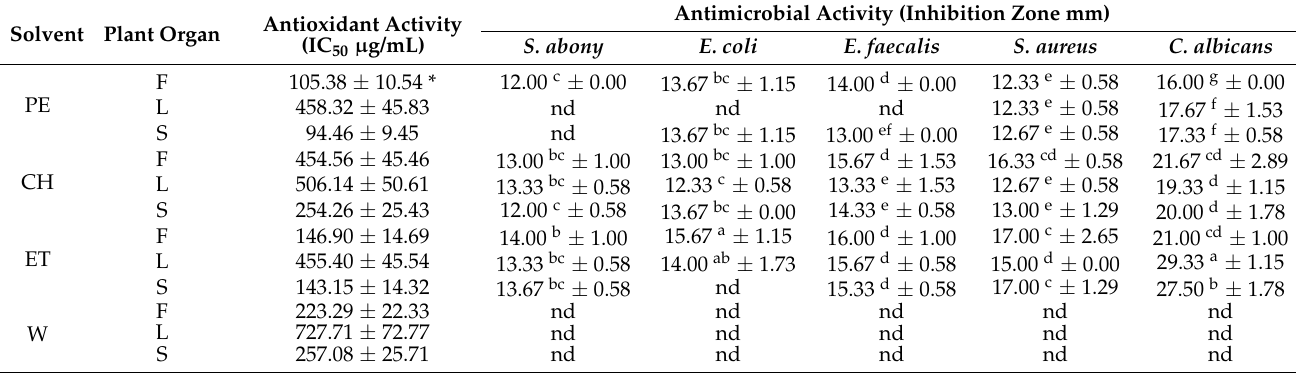
Table 2. Antioxidant and antimicrobial activities of extracts of aerial parts of Gentiana lutea .